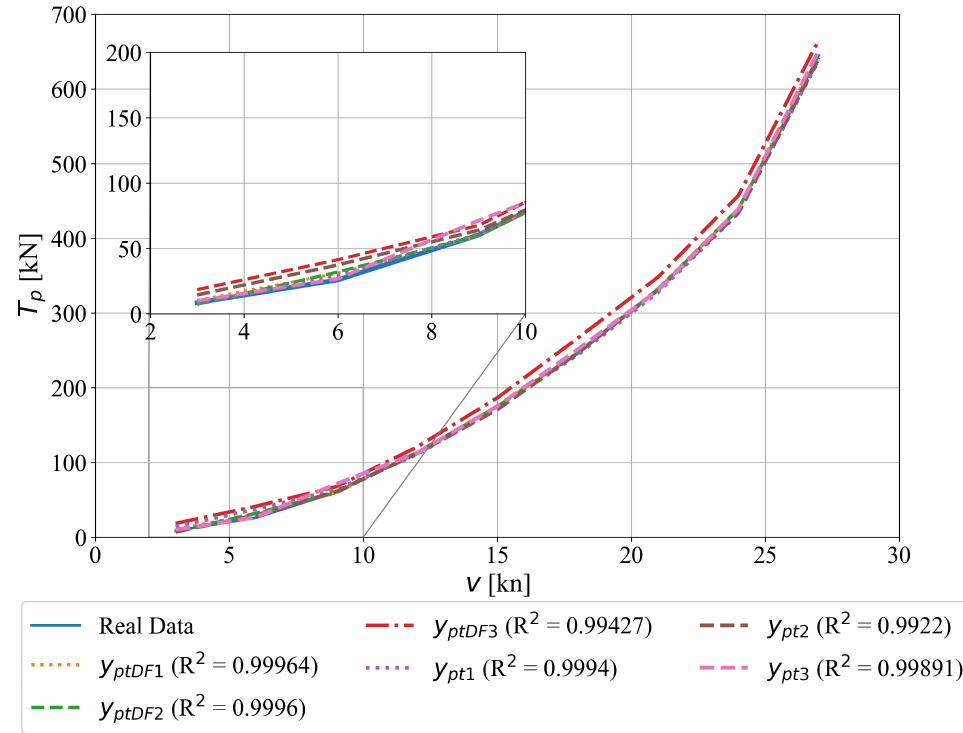
Figure 10. The variation of real and estimated port propeller torque versus the ship